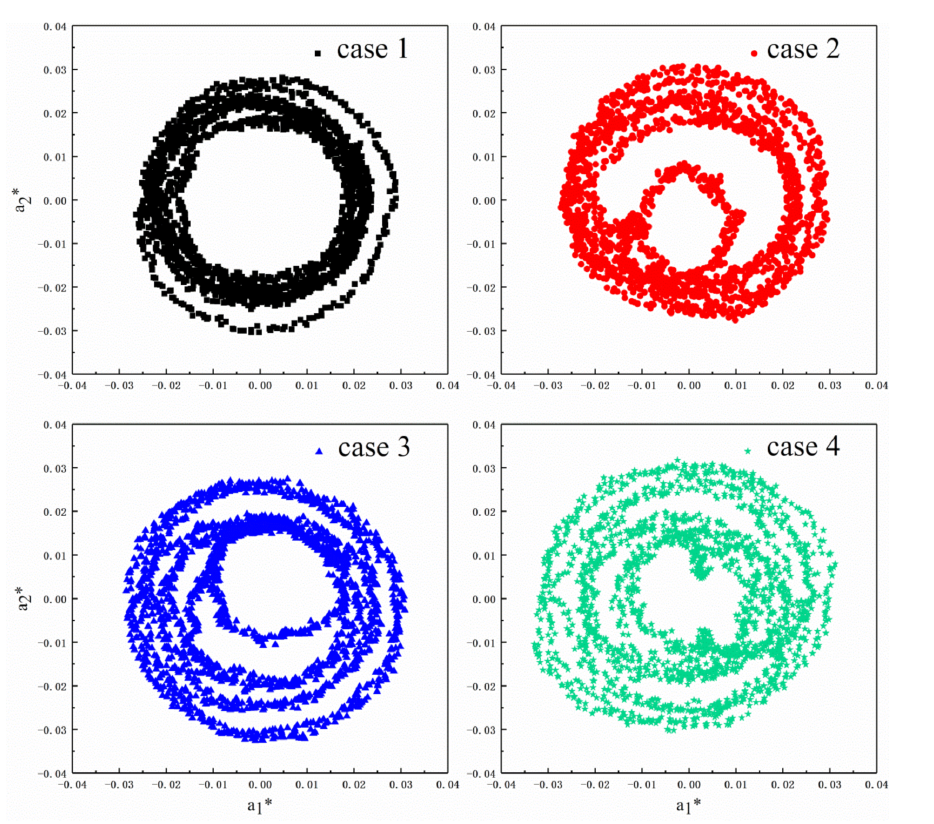
Figure 14. The correlation of POD mode coefficients (Mode 1 and Mode 2) for the smooth cylinder and the dimpled cylinder with different